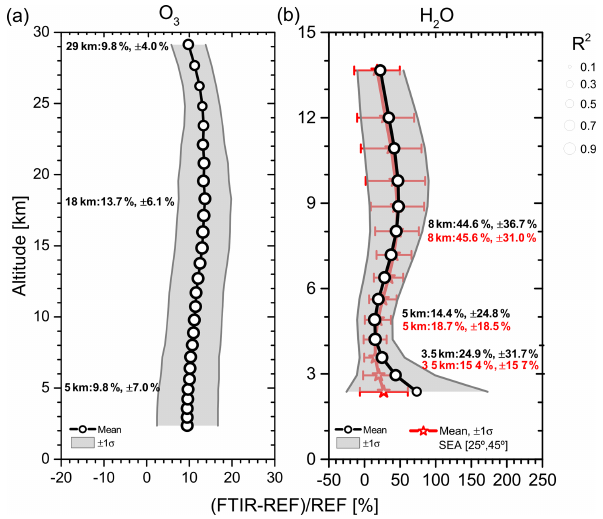
Figure 15. Vertical profile of relative differences between NDACC FTIR VMR profiles and IZO reference data sets (mean and ± 1 σ in %) for (a) O 3 and (b) H 2 O. For the latter, the comparison con- sidering only coincidences for FTIR solar elevation angle between 25–45 ◦ is also included (in red). The dotted area represents determi- nation coefficient, R 2 . Statistics of differences at the altitude levels, well-distinguishable by the FTIR instrument, are included in plots (5, 18, and 29km for O 3 and 3, 5, and 8km for H 2 O). The number of coincident measurements is 276 in the period 1999–2018 for O 3 , and 154 and 32 in the period 2008–2017 for H 2 O without and with limiting the FTIR solar zenith angle,